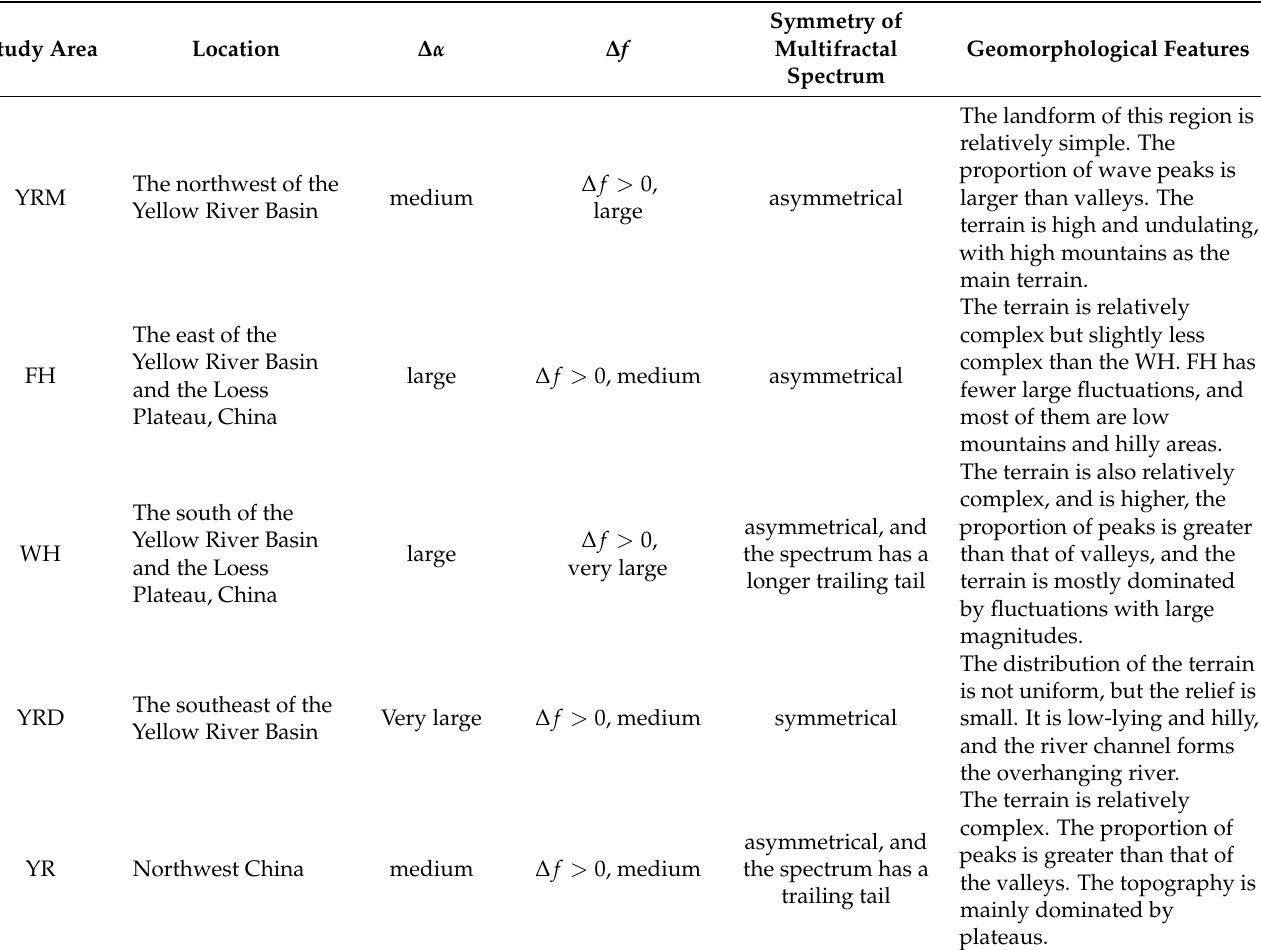
Table 2. A brief summary of topographic features of the study